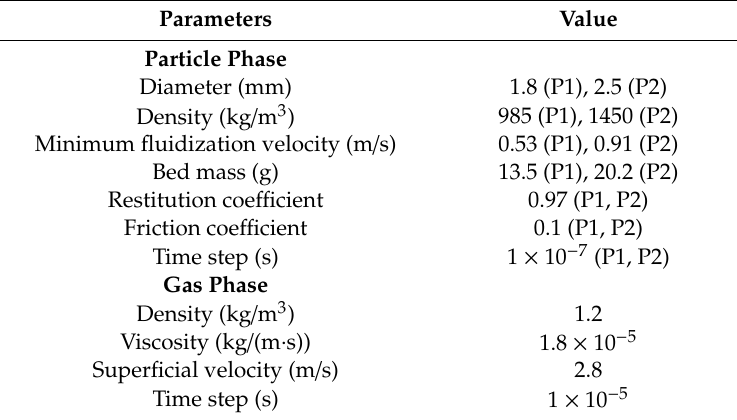
Table 2. Numerical parameters and physical properties of gas and solid phases, P1 for the white particle and P2 for the green